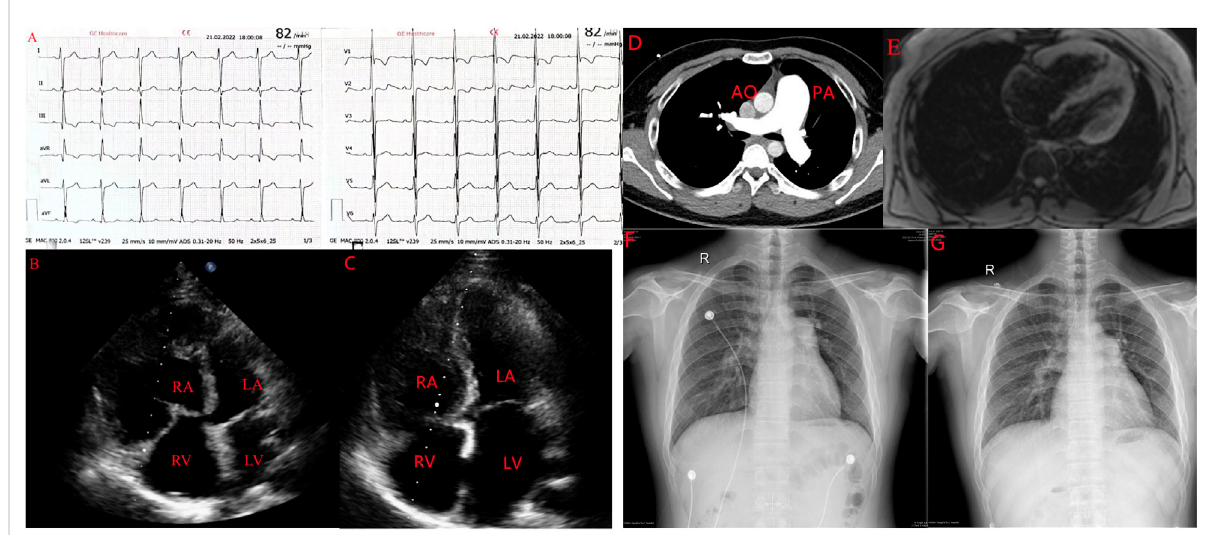
Acaseofle fl unomide-inducedPAHinayoungmalepatientwithnephroticsyndrome. (A) .ElectrocardiographshowingsignsofRVhypertrophy. (B) Echocardiogrph showing enlargement of the right side of the heart. (C) . Enlarged right side of the heart pressing on the LV to form a D sign. (D) . Computed tomography pulmonary angiography showing the ratio of the diameter of the dilated PA to the diameter of the aorta greater than (E) . Cardiac magnetic resonance showing dilationof the right side of the heart, consistent with pulmonary hypertension-induced cardiac changes. AO, aorta; LA, left atrium; LV, left ventricle; PA, pulmonary artery; RA, right atrium; RV, right ventricle. (F,G) Comparison of PA diameter before suspension of le fl unomide and after suspension of le fl